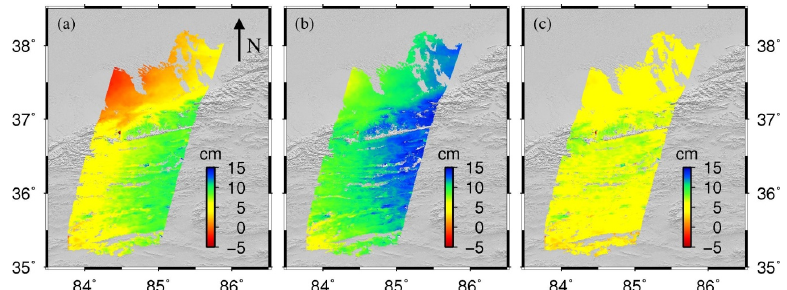
Figure 3. Example interferogram (17 October 2005–19 February 2007) showing the effects of APS and orbit correction. ( a ) observation interferogram; ( b ) APS corrected interferogram (using TRAIN software); ( c ) orbit corrected interferogram (using Biggs’s network correction method).